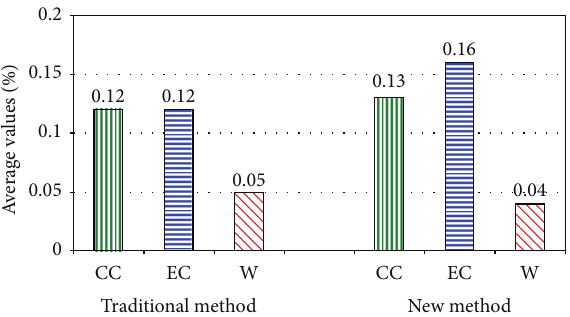
Figure 7: Results of important specific parameters using traditional method and proposed method.